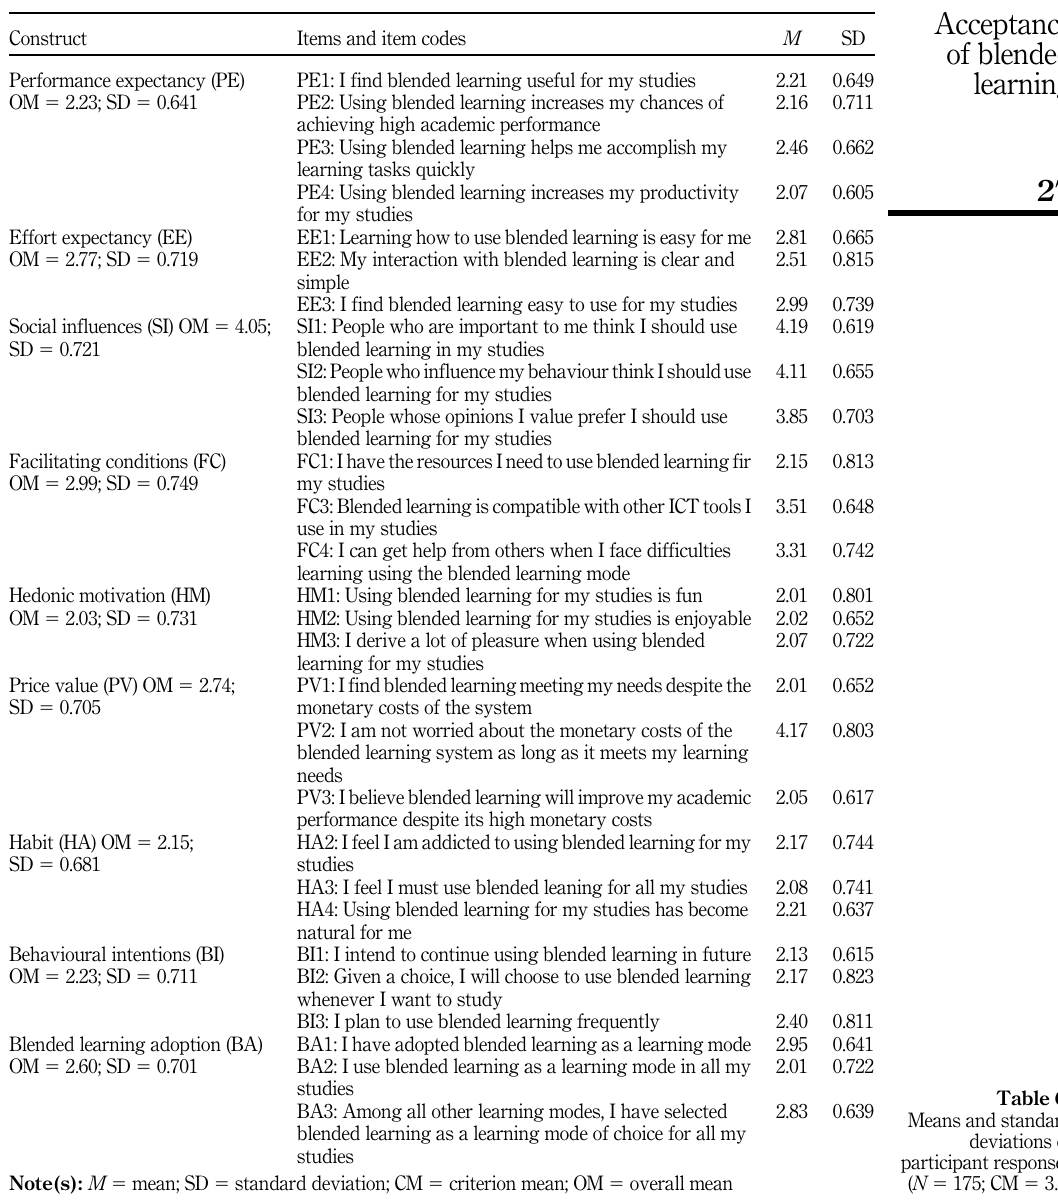
Table 6. Means and standard deviations of participant